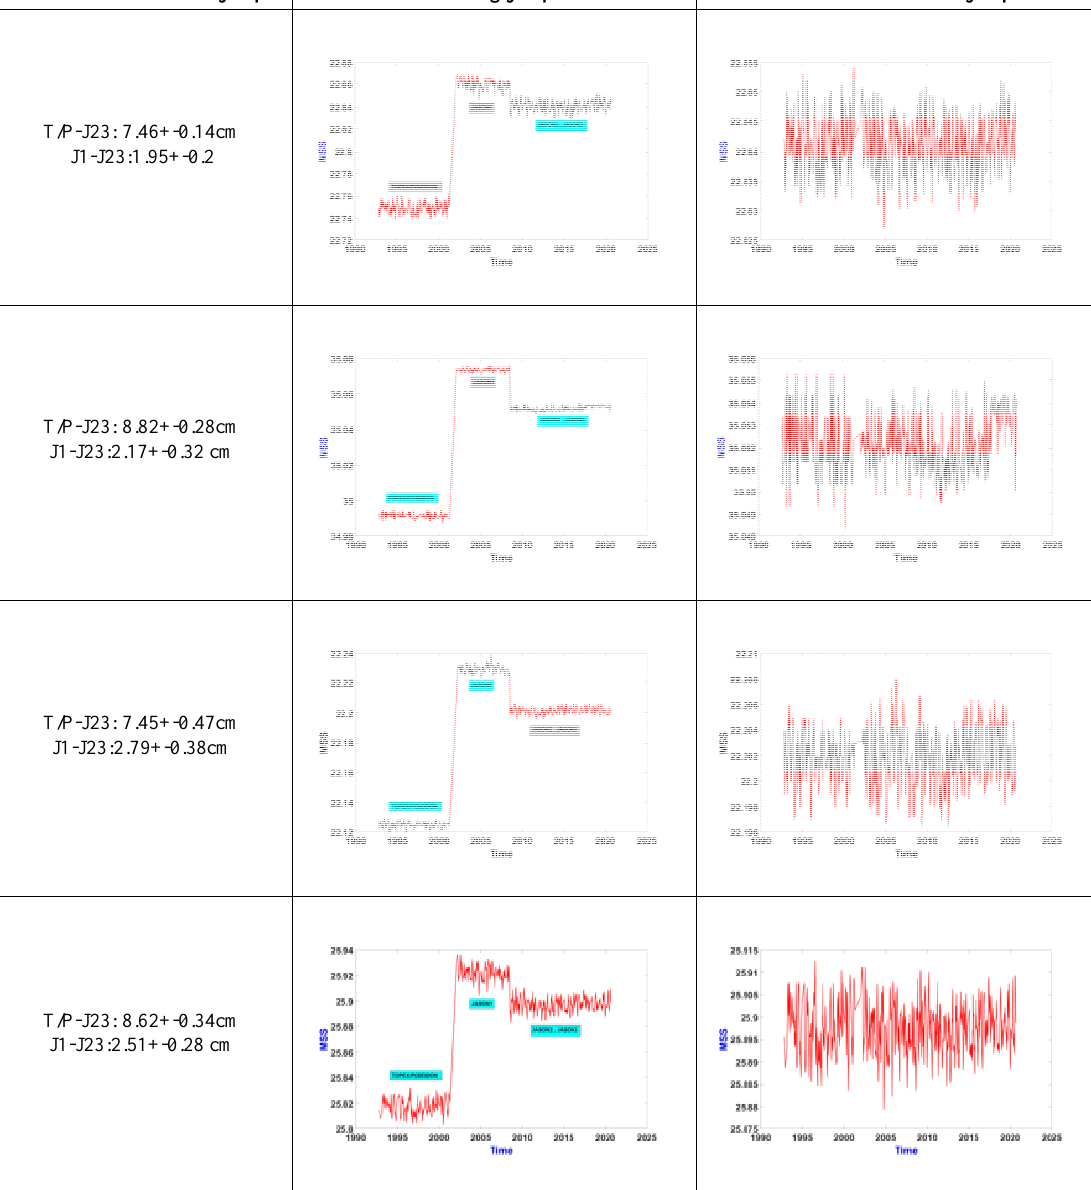
Figure 3 . Plot of MSS values given by GDR files (column 2), the value and STD of the jumps (column 1) and the plots after removal of jumps (column 3) at four sample points over the Baltic